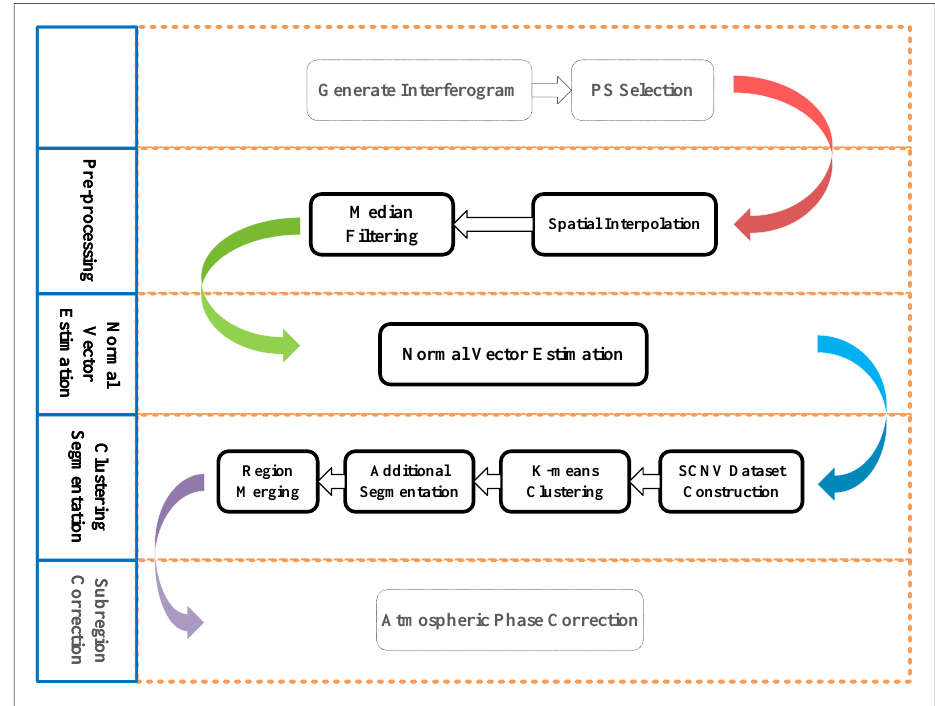
Figure 6. Workflow of the proposed